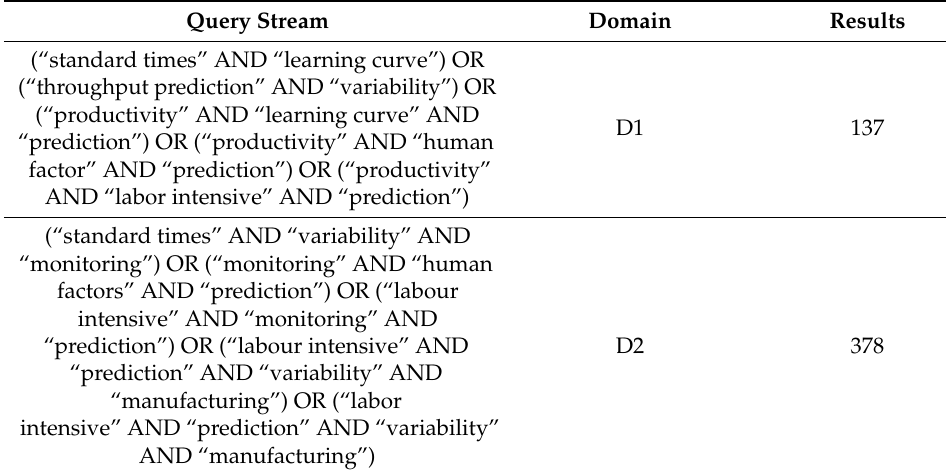
Table 3. Query string executed and initial results. Query Stream Domain